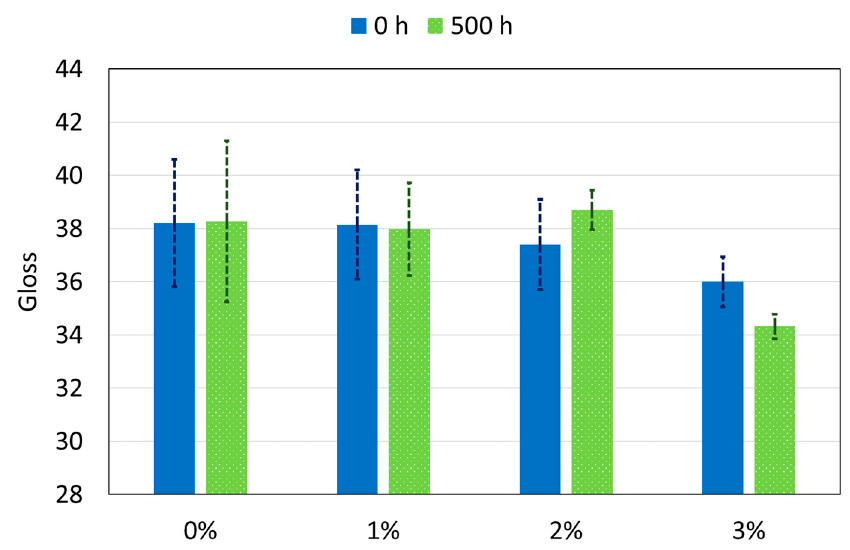
Figure 12. Gloss (60°) of all organic coatings at 0 h and 500 h of xenon exposure.